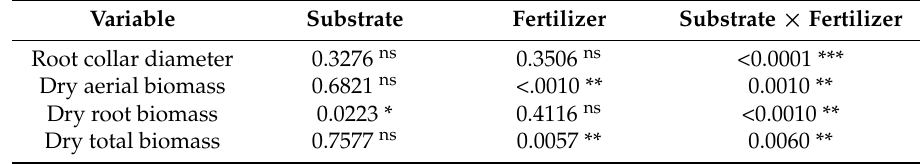
Table 3. Significance values ( p value) based on the response of the substrate, the fertilizer and its interaction, in the variables evaluated in Pinus engelmannii , with the non-parametric Kruskal-Wallis test.